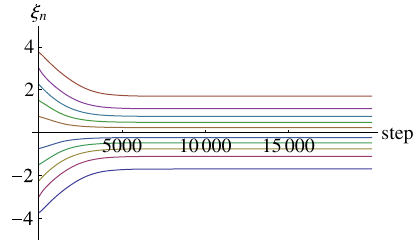
FIG. 3. Convergence of the ensemble of world-particles x ð x 1 ; … ; x N Þ for N ¼ 11 towards the ground-state configuration as a function of the step number in the iteration algorithm described